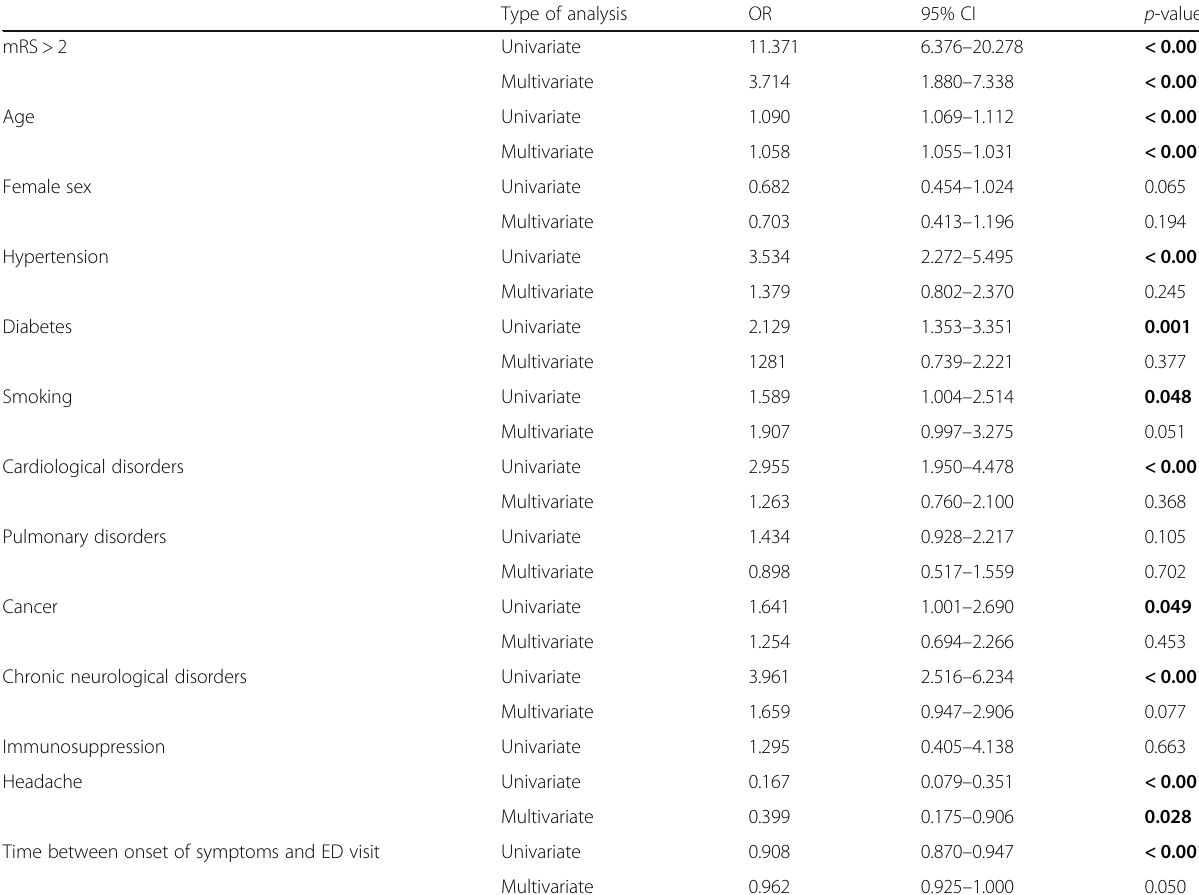
Table 2 Predictors of mortality: univariate and multivariate logistic regression